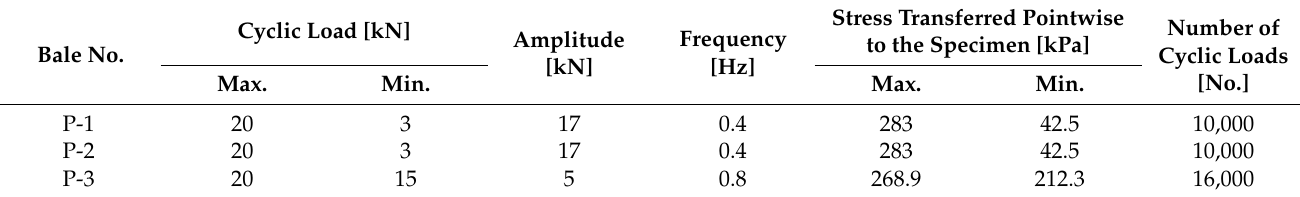
Figure 10. Cyclic test stand: ( a ) overall view; ( b ) bearing surface. The maximum load of 20 kN was applied at a 0.4 and 0.8 Hz frequency to simulate traffic loading (i.e., a standard single wheel load over a typical pavement structure about 800-mm thick). The test was performed for 10 and 16 thousands of load cycles (Table 2). Load and vertical displacement data were measured directly by the actuator and were recorded automatically during testing at 10.0 Hz frequency using the HBM Spider data acquisition system. Table 2. Cyclic load